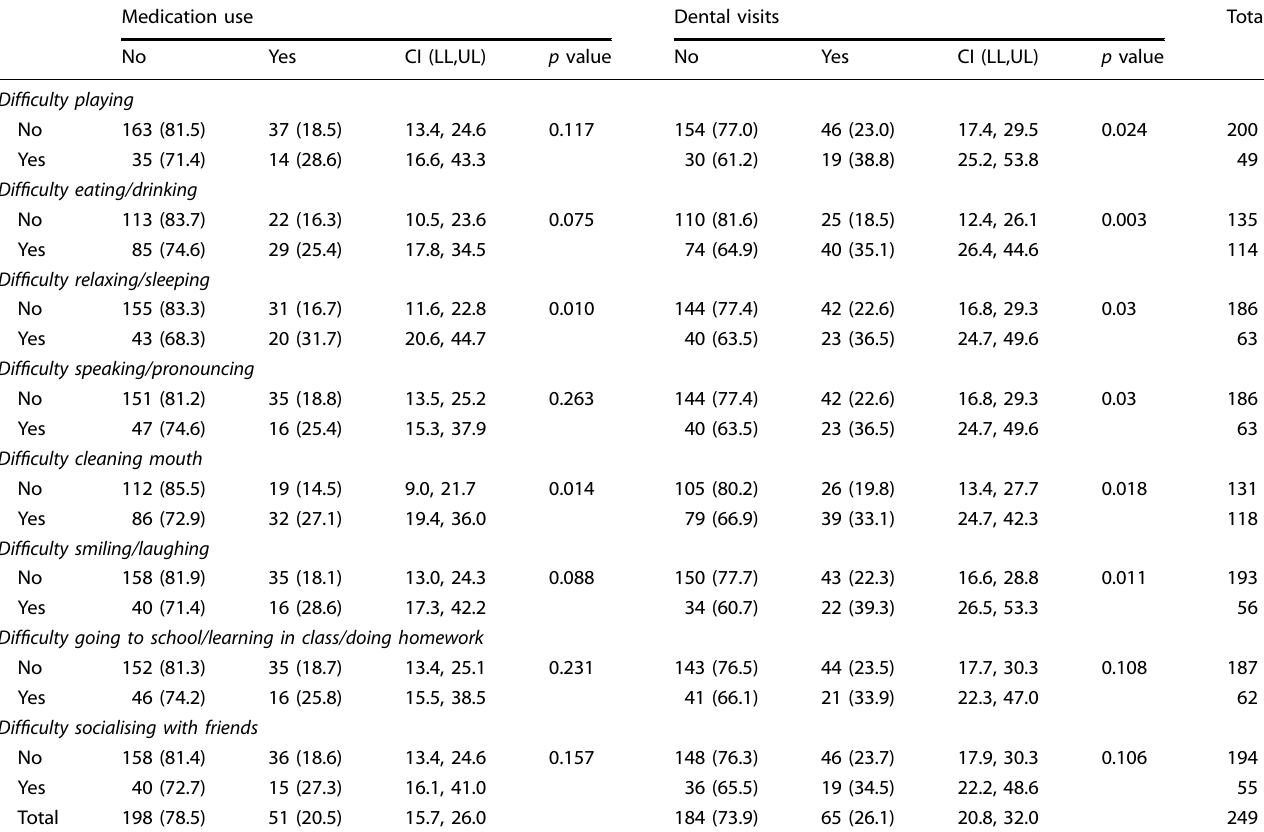
Table 4. Number (%) of students who had used medicine and visited a dentist for tooth pain in the past 1 month, distributed by social impacts. Medication use Dental